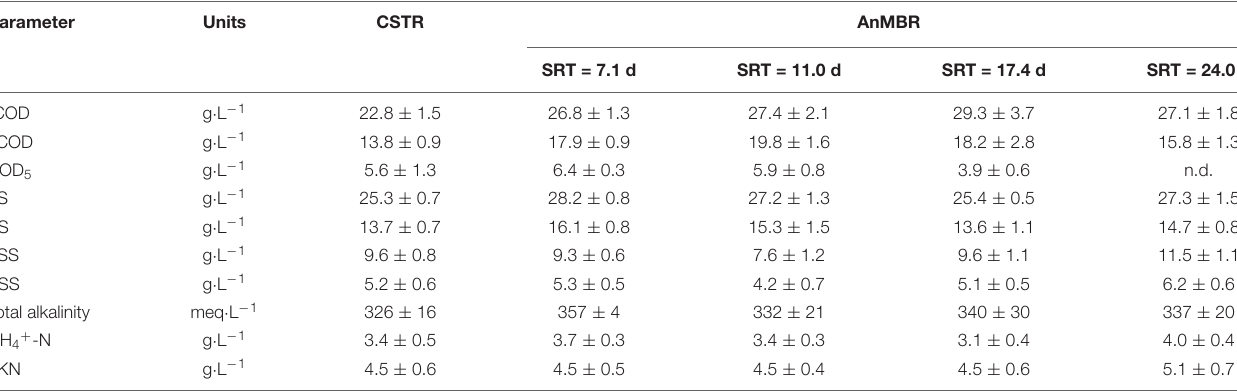
TABLE 1 | Characteristics of the anaerobic supernatant used as influent throughout the experiments when reactor was operated as CSTR or as AnMBR. Parameter